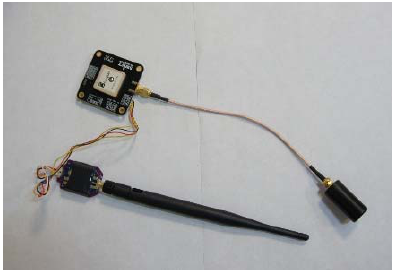
Figure 2. The RTK Module for